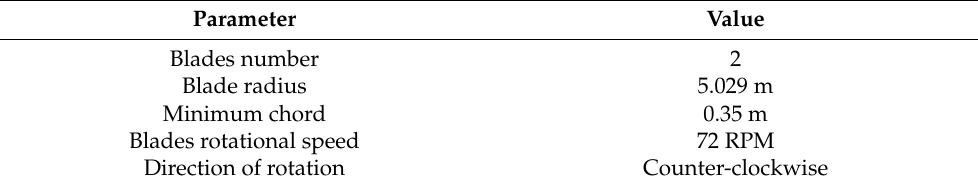
Table 4. NREL phase VI wind turbine parameters.